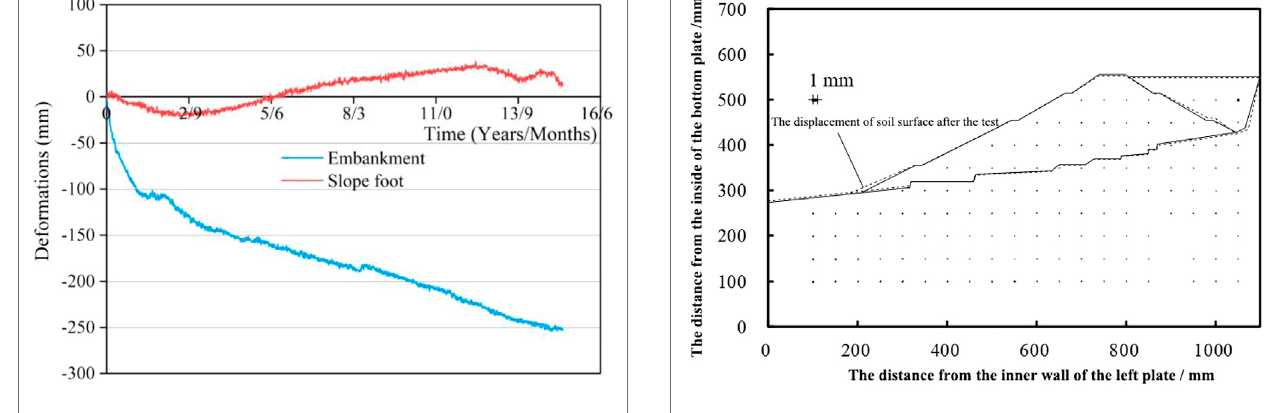
FIGURE 12 | Deformation vector fi eld of the soil pro fi